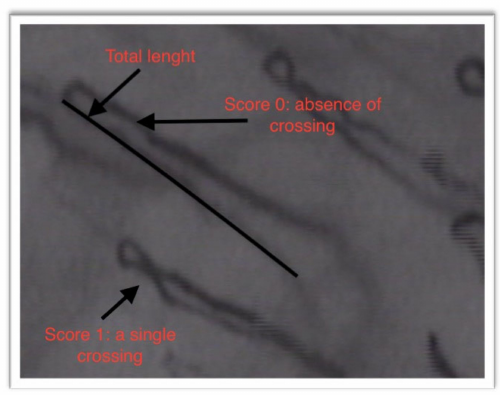
Figure 3. Parametric data: length; non parametric data: the tortuosity of the capillary loops.